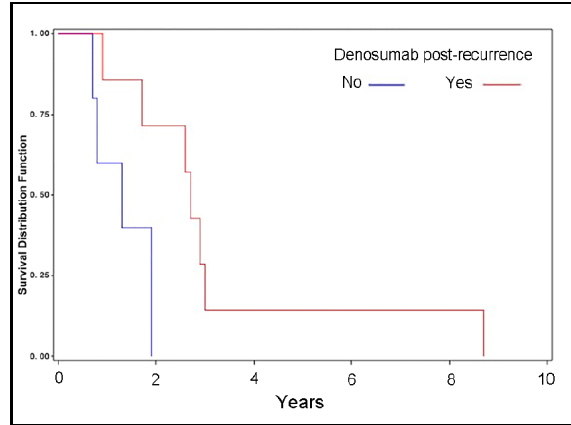
Figure 2: Kaplan Meier curve of progression-free survival in patients who received denosumab post- recurrence vs. those who didn’t Multivariate analysis using Cox regression model was performed. Only denosumab given post-recurrence was found to be of statistical significance for PFS (p=0.034; 95% CI: 0.002-0.581) (Table 3). Table 3: Multivariate analysis of different prognostic factors in the study